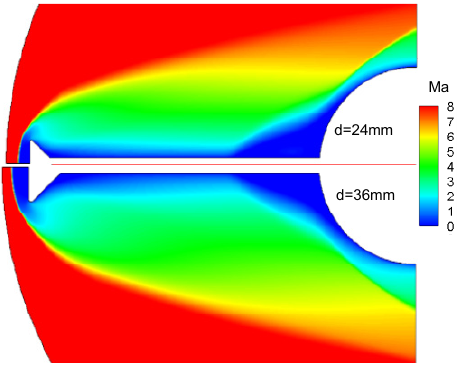
Figure 18. Effect of the diameter of the aerodisk on flow field.